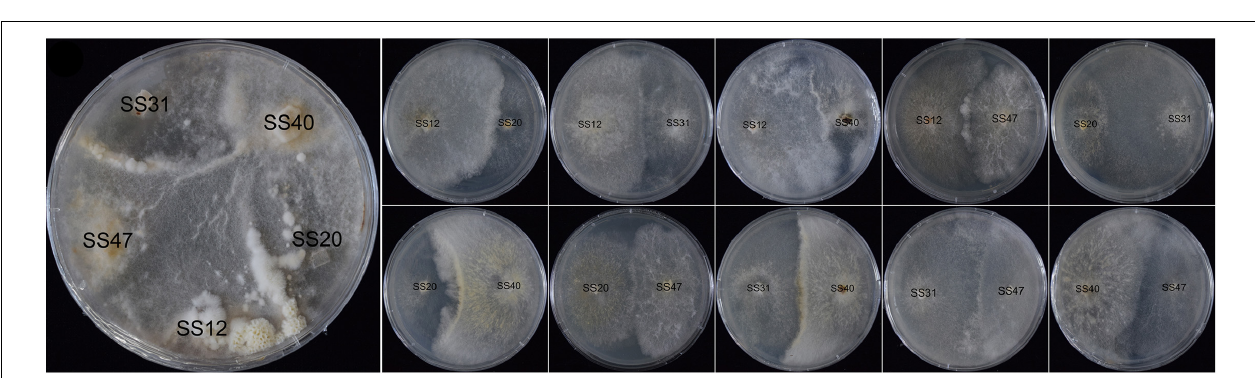
FIGURE 6 | Mating reactions of non-fruiting